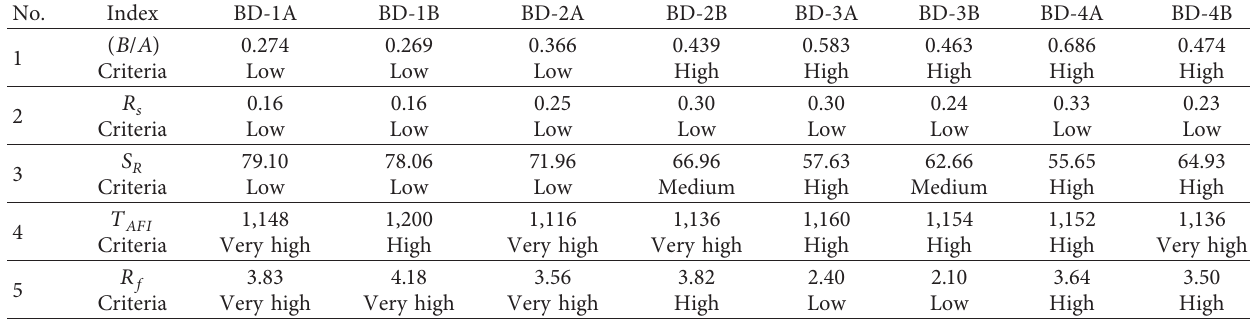
Table 3: Slagging prediction of coal mixture combustion in DTF.